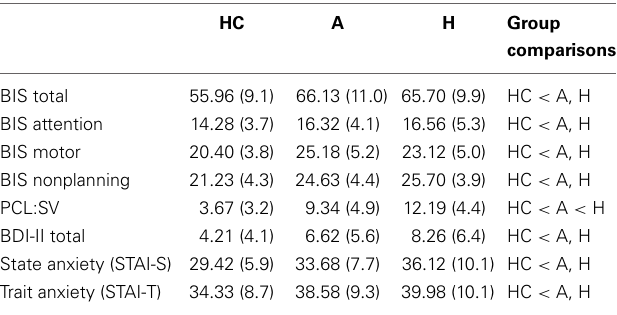
Table 2 | Personality and psychopathology characteristics of participants. HC H Group